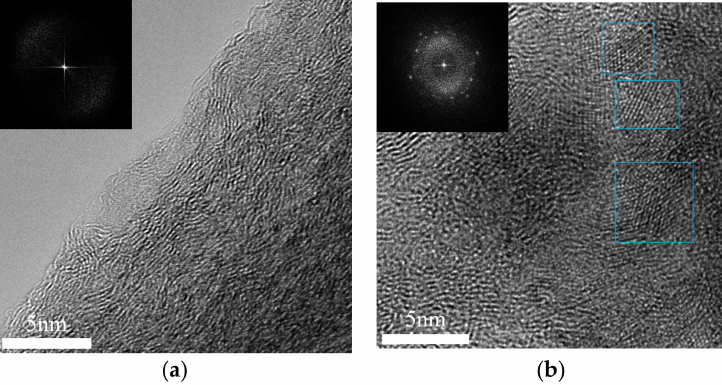
Figure 2. TEM images and the corresponding power spectra of: ( a ) TEOS Carbon; and ( b ) TEOS/Si Hybrid